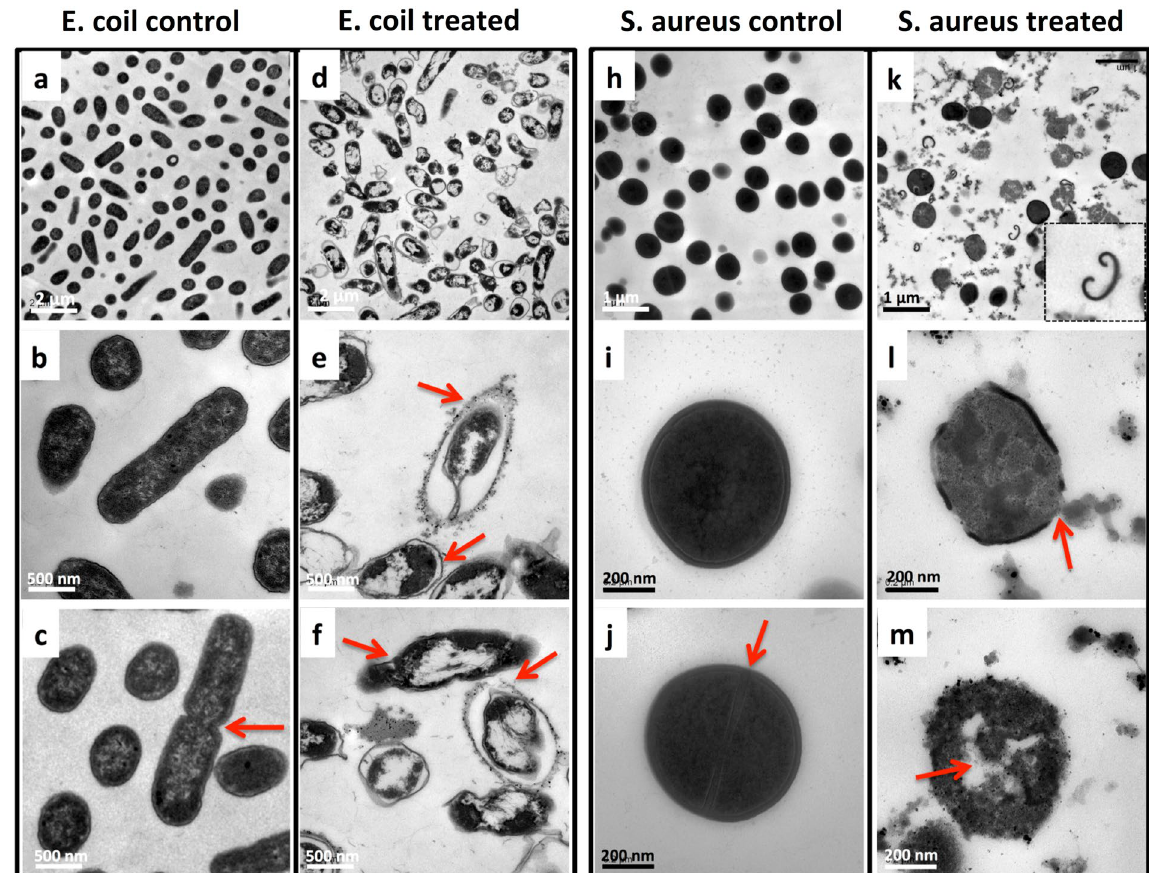
Figure 5. TEM images of bacteria treated with or without CSS-Ag NPs for 8 h. ( a–c ) Untreated E. coil; ( d–f ) treated E. coil; ( h–j ) untreated S. aureus; ( k–m ) treated S. aureus.